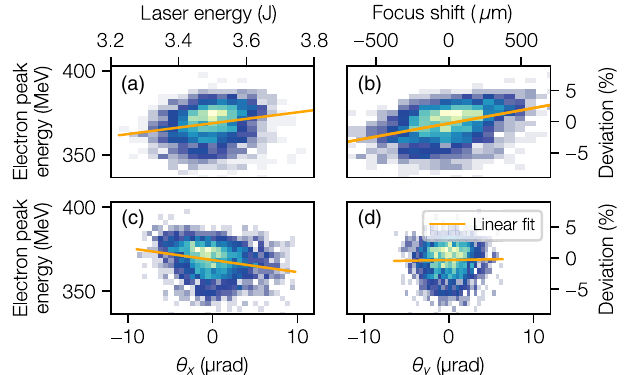
FIG. 3. (a) Electron peak energy correlated with the laser energy E , measured from a mirror leakage after the main amplifier. (b) Longitudinal laser focus position, measured with a wavefront sensor after the compressor. (c,d) Laser angle of incidence θ (pointing), derived from the far field behind the parabola. The correlations are based on a 2-h data subset, as indicated in Fig. 4. The orange line is a linear fit to the correlation. The positions of the wavefront and far-field measurement are shown in Fig.